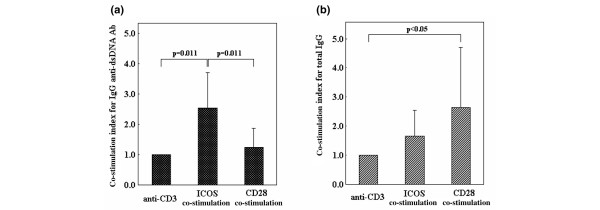
ICOS co-stimulated peripheral blood T cells in active SLE enhanced IgG anti-dsDNA antibody production by autologous B cells. Peripheral blood T cells and B cells were isolated from eight patients with active SLE, reconstituted at a 1:1 ratio and cultured in the presence of anti-CD3 mAb plus JTA009 (ICOS co-stimulation), anti-CD3 mAb plus anti-CD28 mAb (CD28 co-stimulation), anti-CD3 mAb plus JMAb23 (anti-CD3), or without stimulation for 7 days. IgG anti-dsDNA antibody and total IgG were determined by ELISA. The mean ± SD production of IgG anti-dsDNA antibody and total IgG, respectively, were as follows: anti-CD3 mAb plus JMAb23, 45.4 ± 64.4 U/ml and 274± 141 ng/ml; ICOS co-stimulation, 98.3 ± 118 U/ml and 475 ± 297 ng/ml; CD28 co-stimulation, 46.1 ± 64.1 U/ml and 734 ± 694 ng/ml; and without stimuli, 22.0 ± 29.7 U/ml and 216 ± 180 ng/ml. Co-stimulation indices for (a) IgG anti-dsDNA antibody and (b) total IgG were calculated as follows: the IgG anti-dsDNA antibody or total IgG production with co-stimulation/the IgG anti-dsDNA antibody or total IgG production with anti-CD3 mAb plus JMAb23. Differences between stimuli were evaluated using Wilcoxon rank sum test. Ab, antibody; ds, double stranded; ICOS, inducible co-stimulator; SD, standard deviation; SLE, systemic lupus erythematosus.